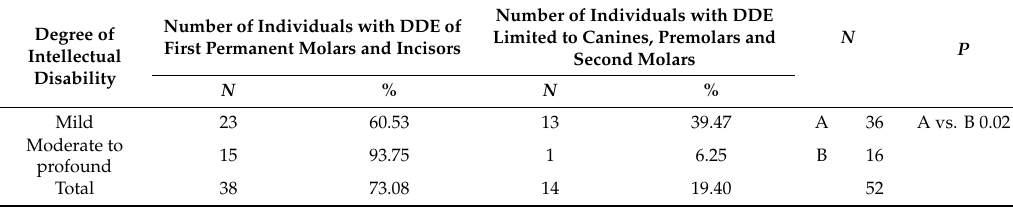
Table 5. Mann–Whitney U test did not reveal statistically significant di ff erences between the DMFT numbers of subjects with mild and more advanced degrees of intellectual disability (4.56 ± 3.85 vs.